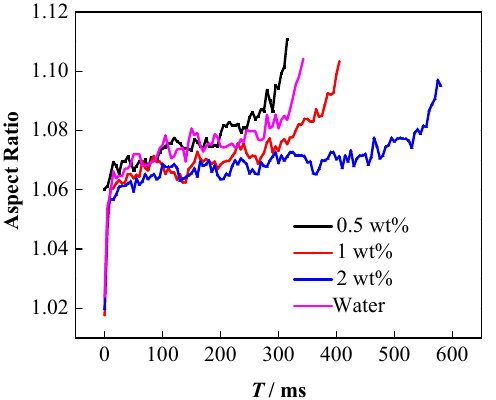
Figure 8. Effect of particle concentration on degree of deformation.